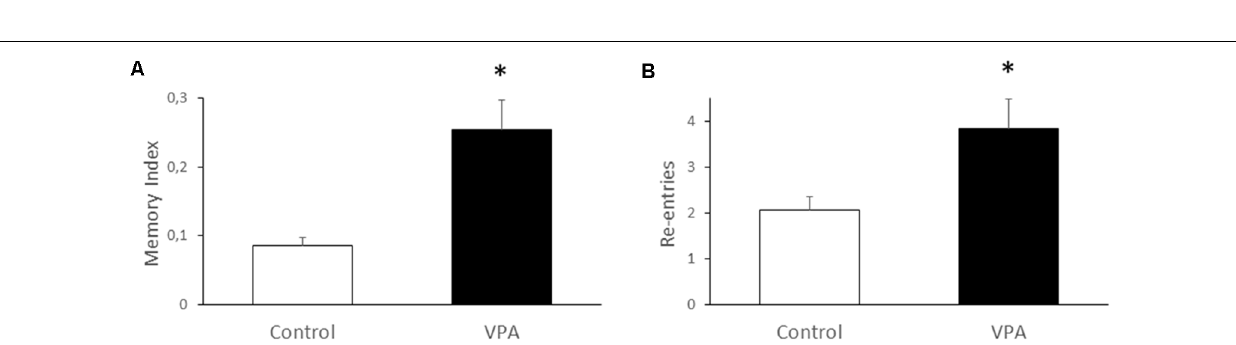
FIGURE 6 | Effect of prenatal VPA treatment on spatial memory and repetitive behavior in the Y-maze. Prenatal VPA treatment improves spatial memory in Y-maze test (A) . Spatial memory was evaluated by the permanence index, expressing the proportion of the time spent in the novel arm, in relation to the time spent in the novel plus the known arm. The number of reentries in the same arm was evaluated as a repetitive behavior during the Y-maze test (B) . The data are expressed as the mean ± SEM. ∗ p < 0.05, U -test. n = 13 for controls and n = 5 for VPA-treated